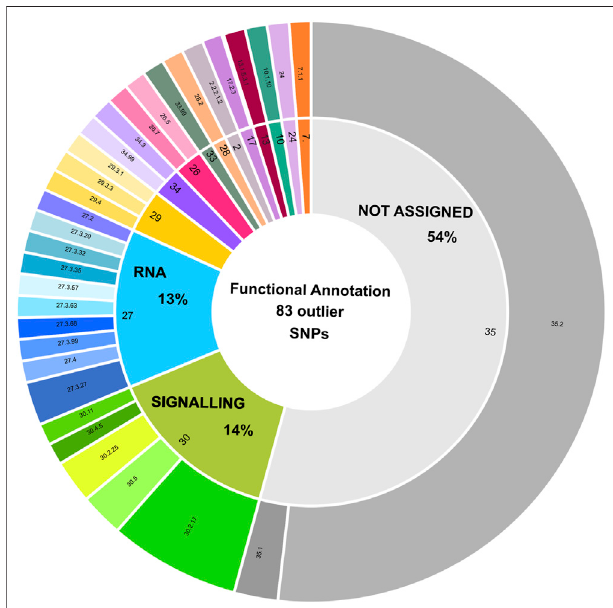
FIGURE 4 | Functional annotation of 83 outlier loci displaying a positive match with transcribed regions. Functional annotation of SNPs with a positive blast hit against C. nodosa transcriptomes is depicted using a sunburst diagram. Each sequence has been assigned to aMapMan BIN category and sub-category based on its biological role or enzymatic activity. The de fi nition of the BINs is included in the fi gure legend. A detailed description of BIN sub-categories can be retrieved from Supplementary Table S12